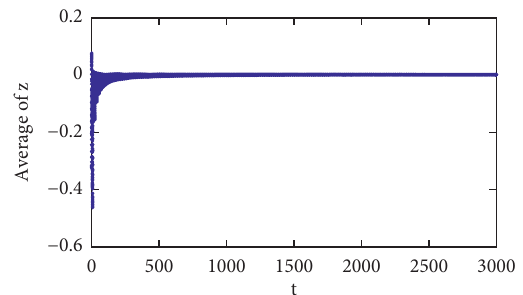
Figure 3: Time averaged value of z ( t ) for system (1) with a � − 6 . 17 ,b � − 1 ,c � 1 , and e �